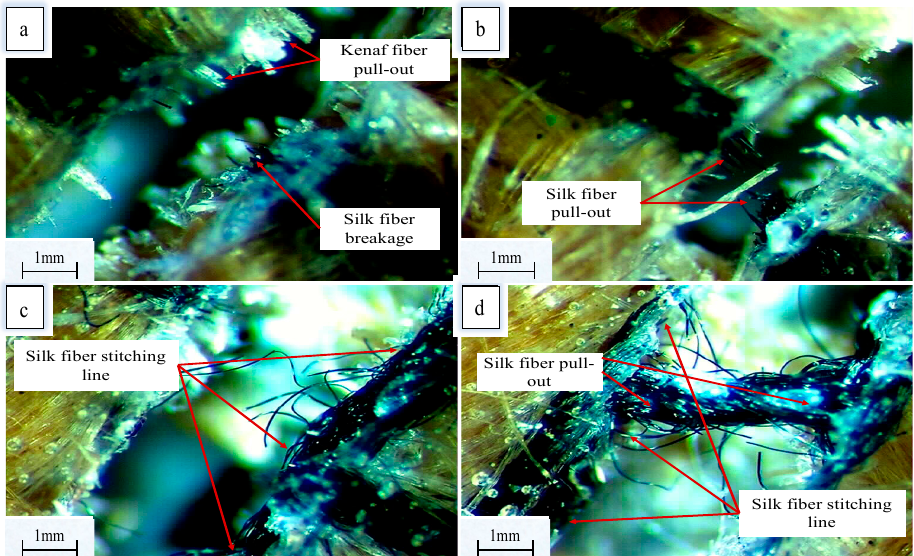
Figure 16. Stereomicroscope photos for the fractured surfaces: ( a , b ) WKS / X stitched specimens; ( c , d ) WKS / XY stitched specimens.